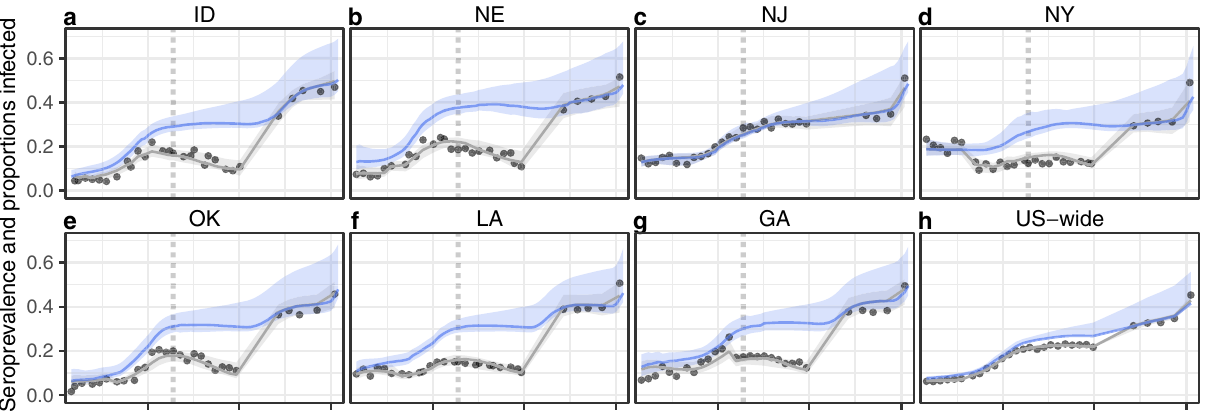
Fig. 3 | Time series of survey seroprevalence and estimated proportions infected for seven example states and U.S.-wide. Example time series of survey seroprevalence, fi tted seroprevalence and estimated proportion infected for ( a ) Idaho, ( b ) Nebraska, ( c ) New Jersey, ( d ) New York, ( e ) Oklahoma, ( f ) Louisiana, ( g ) Georgia, and ( h ) the United States. For all of these states, seroprevalence was estimated primarily using the Abbott assay prior to September 2021 (see Supple- mentary Figs. 1 and 3), except for ( c ) New Jersey, for which the Roche assay was exclusively used. The proportion infected was estimated using the best waning logistic regression by LOO median RMSE (Fig. 2 and Table 1). U.S.-wide estimates